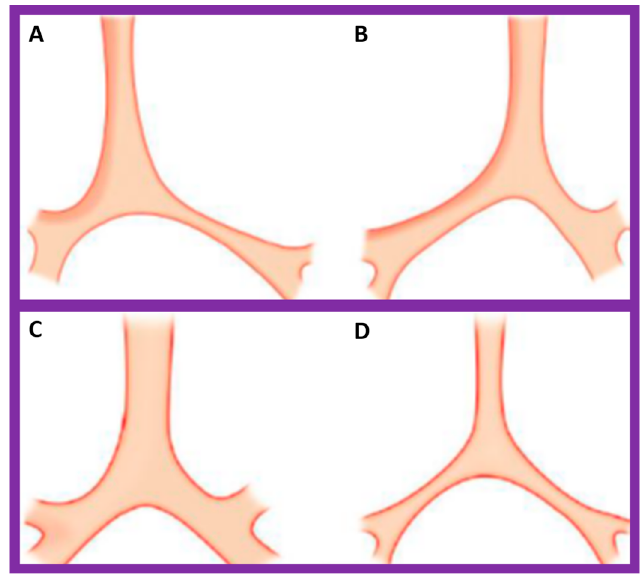
Figure 22. Diagrammatic depiction of the anatomy of the tracheobronchial tree. ( A ) In patients with situs solitus, the right bronchus is short and wide and inclines somewhat steeply, whereas the left bronchus is long and narrow and traverses in a horizontal pattern. ( B ) In patients with situs inversus, the configuration of the bronchial pattern is inverted; the morphologic right bronchus is on the left side, while the morphologic left bronchus is on the right side. ( C ) In patients with heterotaxy (asplenia syndrome), both right and left bronchi have the morphology of the right bronchus. ( D ) In subjects with heterotaxy (polysplenia syndrome), both the right and left bronchi have the appearance of morphologic left bronchi. Concept is derived from Reference [2], and the Figure is modified from Reference [5].